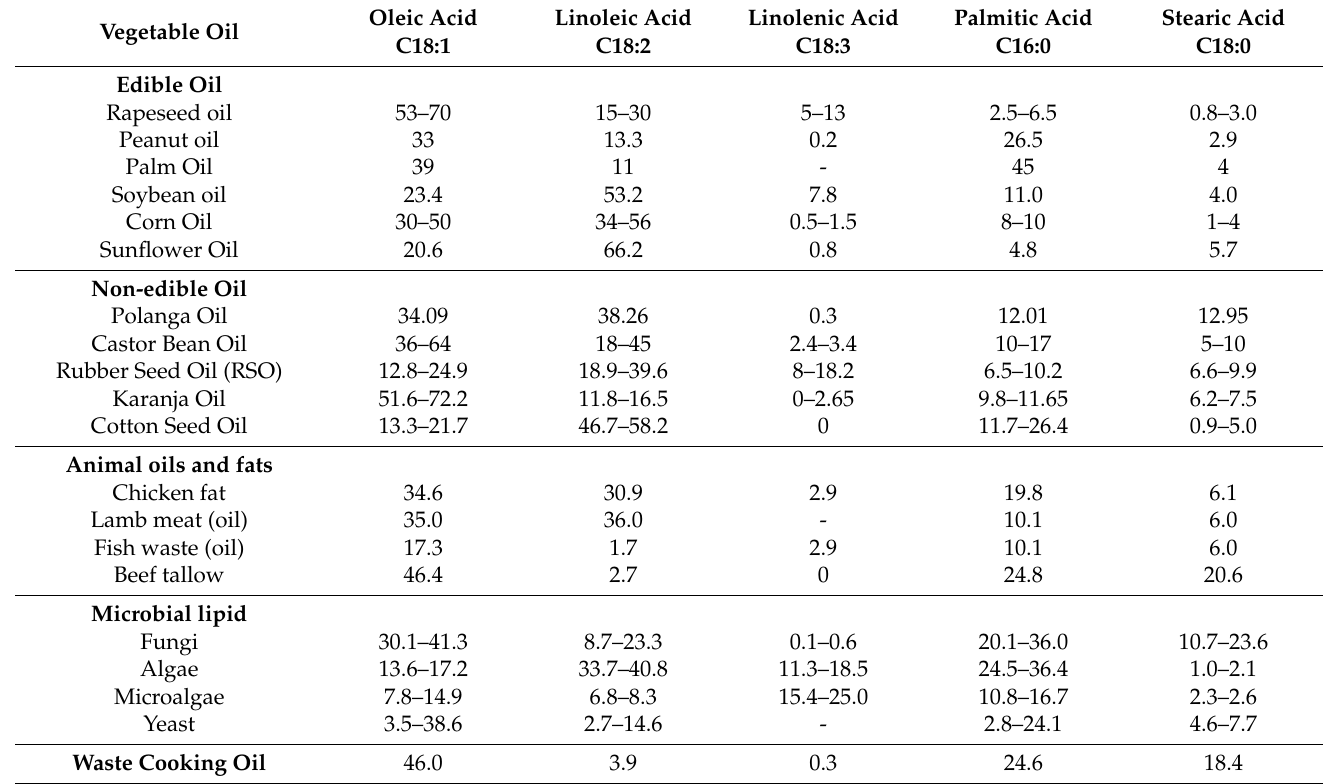
Table 1. Fatty acids composition in various feedstocks